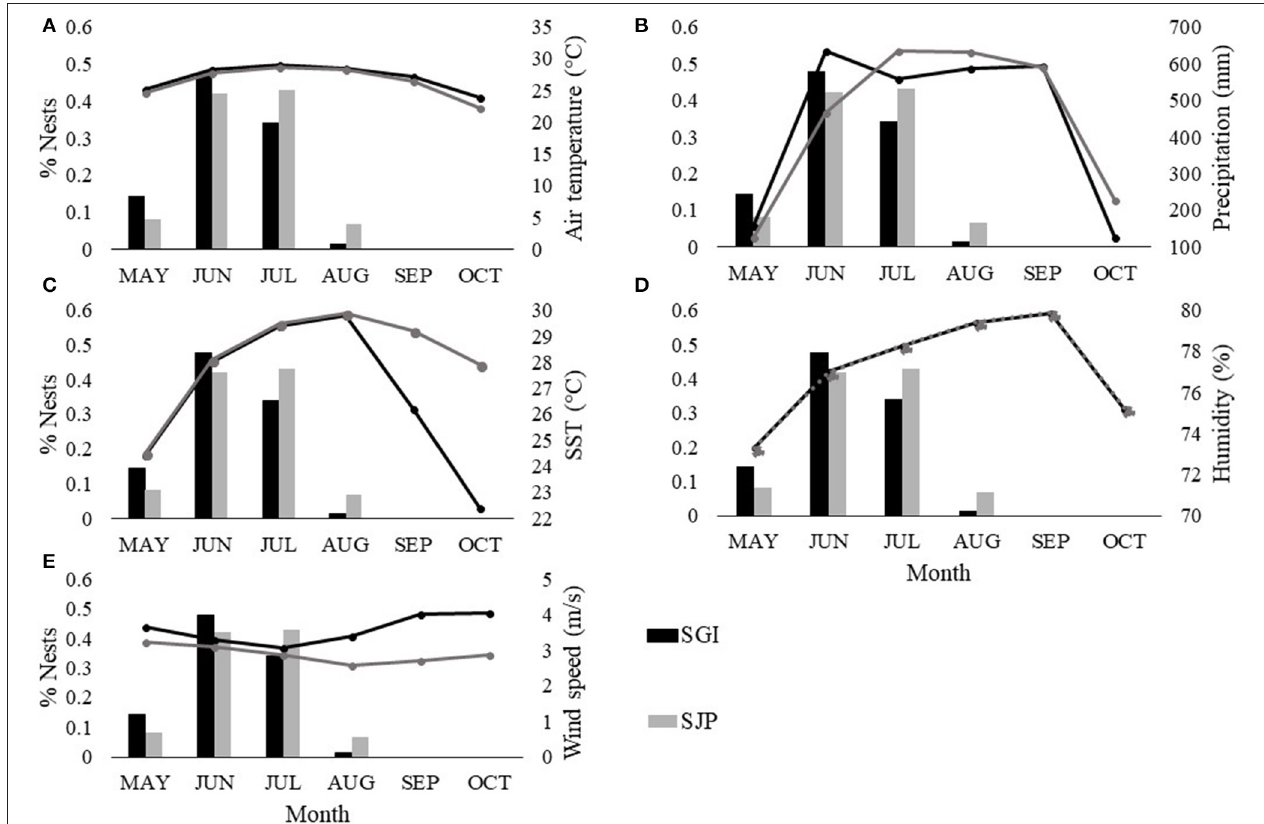
FIGURE 3 | Monthly averaged climatic conditions (lines) at T.H. Stone Memorial St. Joseph Peninsula (SJP) (gray) and St. George Island (SGI) (black) and monthly proportions of nests laid (bars) between 2013 and 2016 at SJP (gray) and SGI (black). Climate variables include: (A) air temperature ( ◦ C), (B) accumulated rainfall (mm), (C) sea surface temperature ( ◦ C), (D) humidity (%), and (E) wind speed (m/s). Dotted line in (D) represents overlapping values. Between 2013 and 2016 at SJP, a total of 17 loggerhead nests were laid and left undisturbed in May, 90 in June, 90 in July, and 14 in August. At SGI, a total of 18 loggerhead nests were laid and